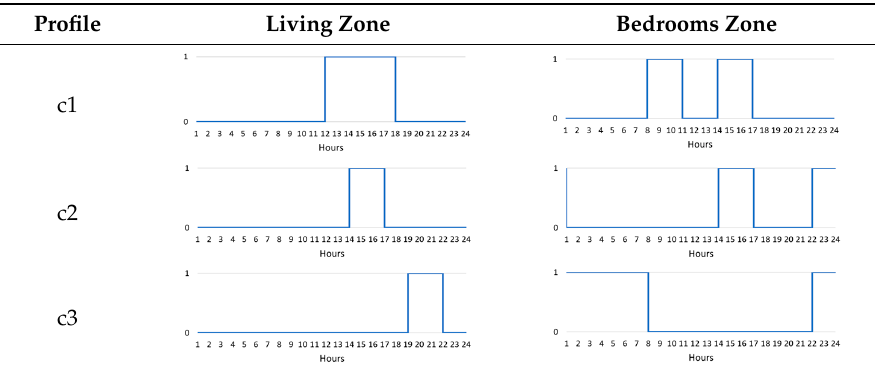
Table 3. Daily cooling schedules (On = 1, Off = 0).